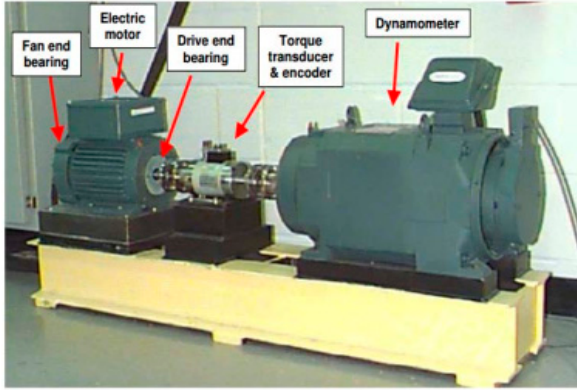
Figure 4. Case Western Reserve University seed fault bearing testbed [18]. Table 1. Dataset for single bearing faults.